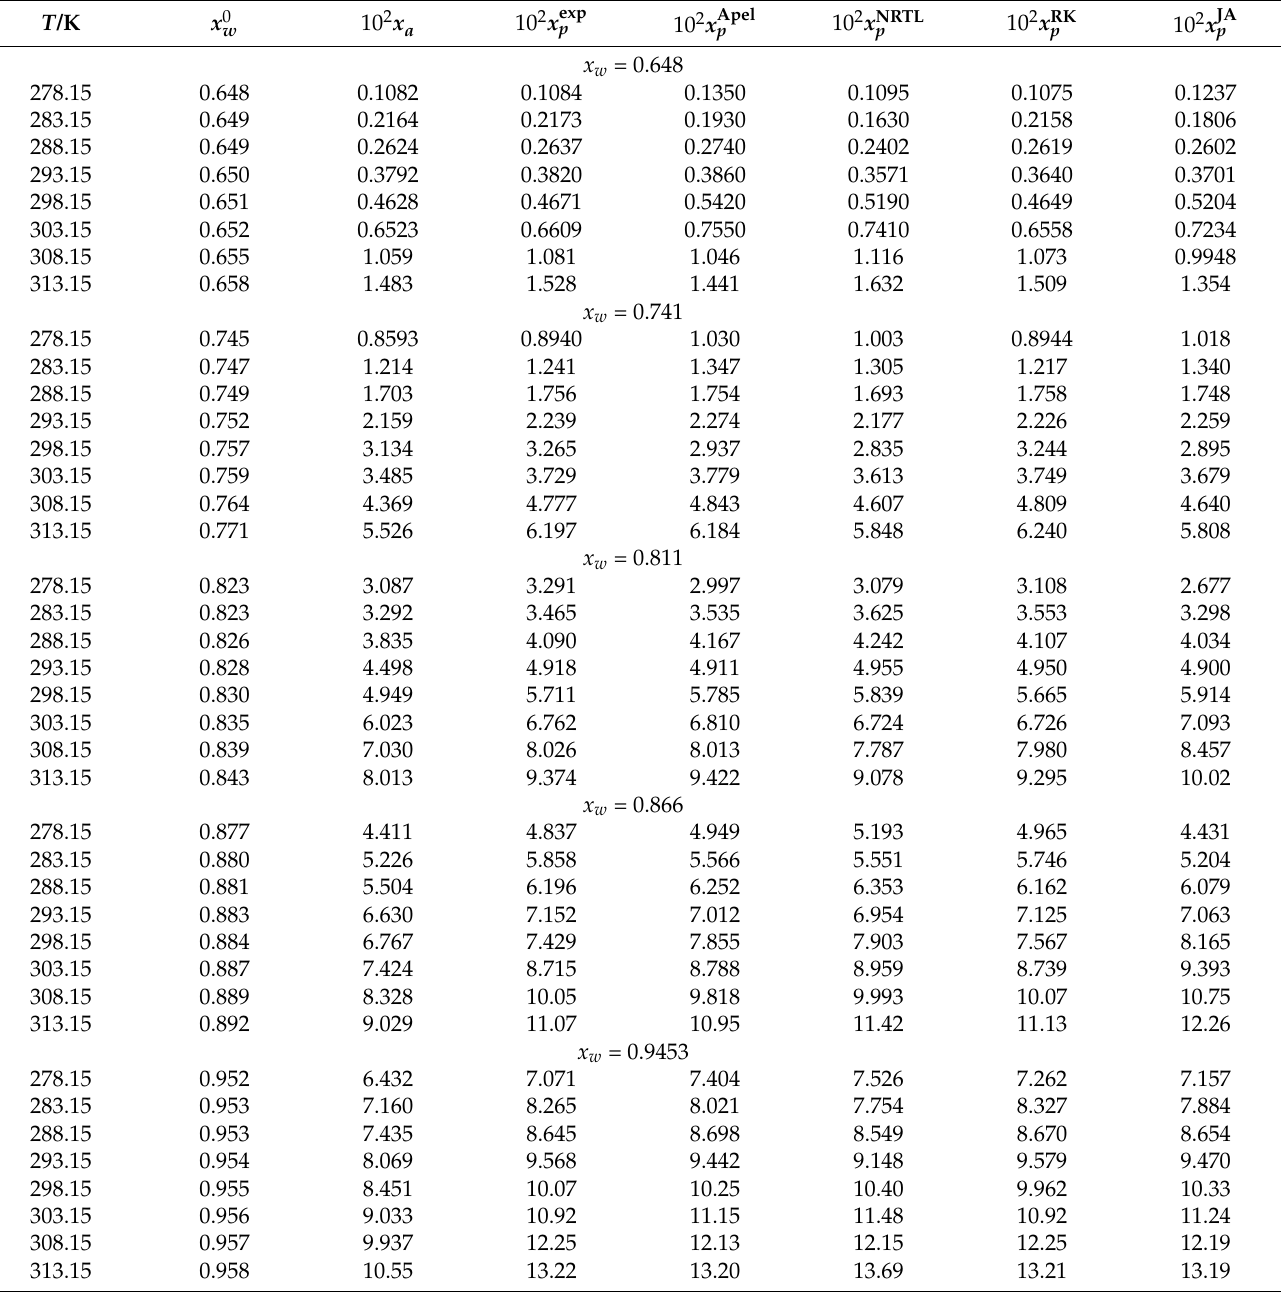
Table 5. Mole fraction solubility of 1,5-pentanediamine adipate dihydrate in water + DMF